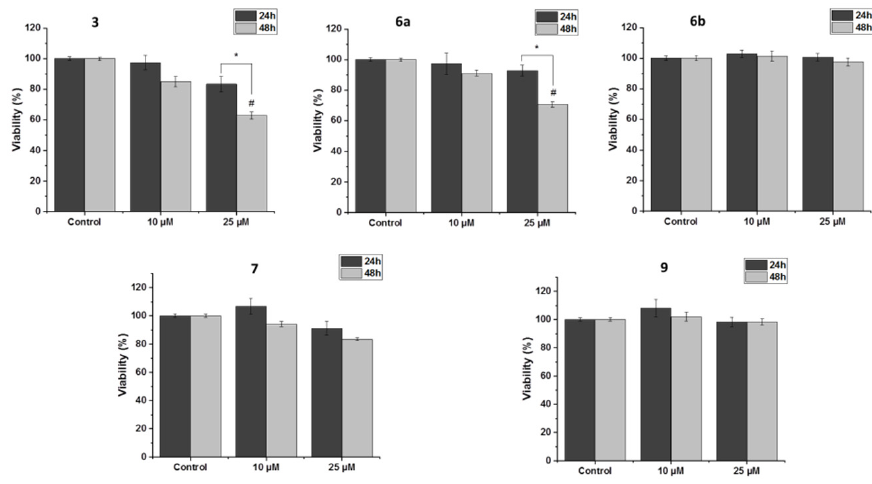
Figure 3. The effects of compounds 3 , 6a , 6b , 7 and 9 on the viability of MCF7 cells, evaluated by MTT assay. Cells were treated with 10 µ M and 25 µ M for 24 h or 48 h. Data are shown as mean ± SEM of at least three separate experiments. * p < 0.05 compared with the untreated cells. #: p < 0.05 compared with the cells treated with 10 µ M solutions.